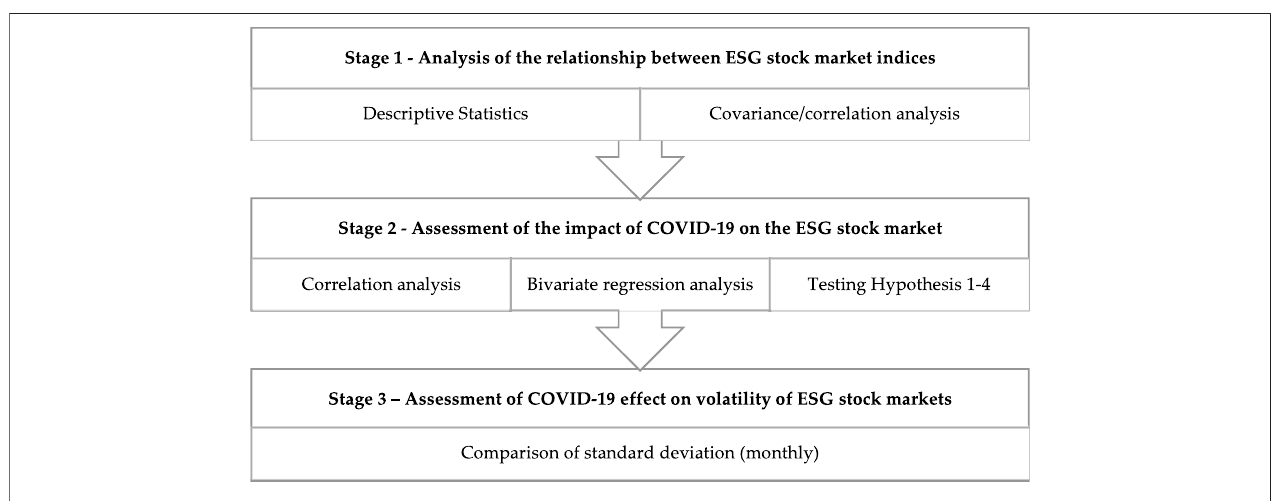
FIGURE 1 | Research